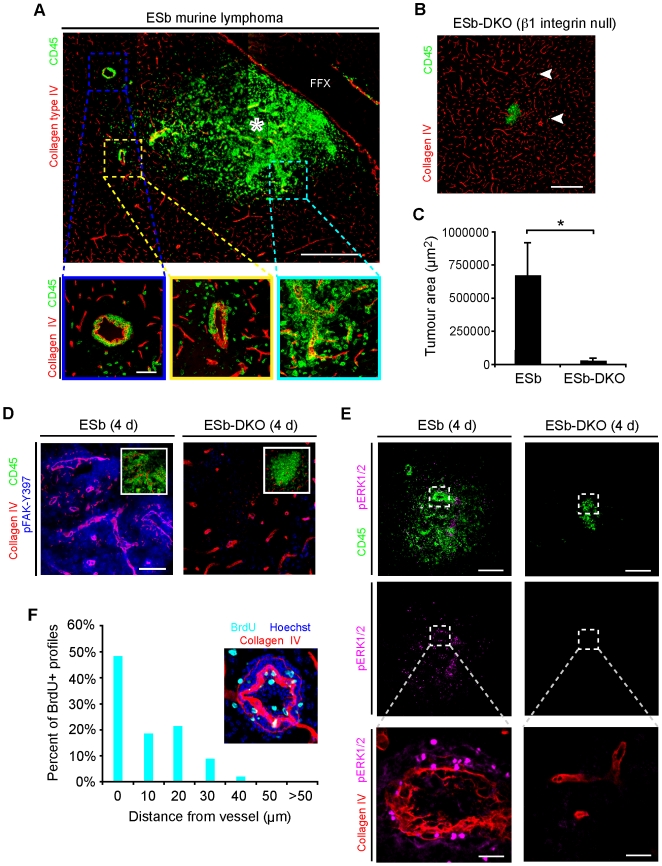
β1 integrin is required for angiocentric growth of tumor cells in the CNS in vivo.(A) Representative montage demonstrates tumor growth and invasion of ESb cells (CD45+, green) from the point of initial injection (asterisk). Despite the ability of single cells to migrate through the brain parenchyma there was a clear preference for growth upon vessels (hatched areas, lower panels). Inset, lower left demonstrates BrdU+ (cyan) perivascular ESb cells. Scale bar, 500 µm (montage), 60 µm (bottom micrographs). FFX, fimbria/fornix bundle. (B) in vivo growth of ESb-DKO murine lymphoma cells (β1 integrin null) is highly impaired relative to ESb cells (A). Long-distance migration of single cells is not affected (arrowheads). Scale bar, 240 µm. (C) Tumor area was nearly 22 times greater in the ESb compared to the ESb-DKO line at 4 d (*p<0.01; error bars represent s.d.; n = 3–4). (D) Immunohistochemistry for activated FAK (pFAK-Y397) demonstrates strong staining in perivascular wild-type ESb cells (left) but little staining in ESb-DKO cells (right). Scale bar, 60 µm. Asterisk, injection site. (E) Immunohistochemistry for activated ERK (pERK1/2) shows strong nuclear staining and moderate cytoplasmic staining of perivascular ESb lymphoma cells (left) but not in ESb-DKO cells (right). Scale bars, 240 µm (top) and 30 µm (bottom). (F) Histogram demonstrating perivascular distribution of BrdU+ profiles in animals injected with ESb cells (cyan). The majority of BrdU+ profiles are within 1 cell diameter of vessels (mean ± s.d. distance: 7.5±9.4 µm).